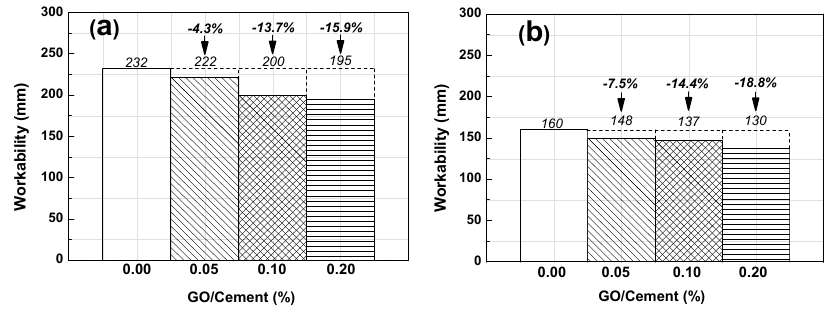
Figure 6. Workability results of admixture with different amount of GO: ( a ) Paste; ( b ) Mortar.